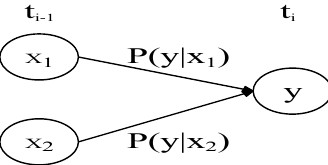
Figure 1. Dynamic Bayesian Network. (Note: X 1 , X 2 are parent nodes, y is child nodes, and t i − 1 , t i . represent different times.).